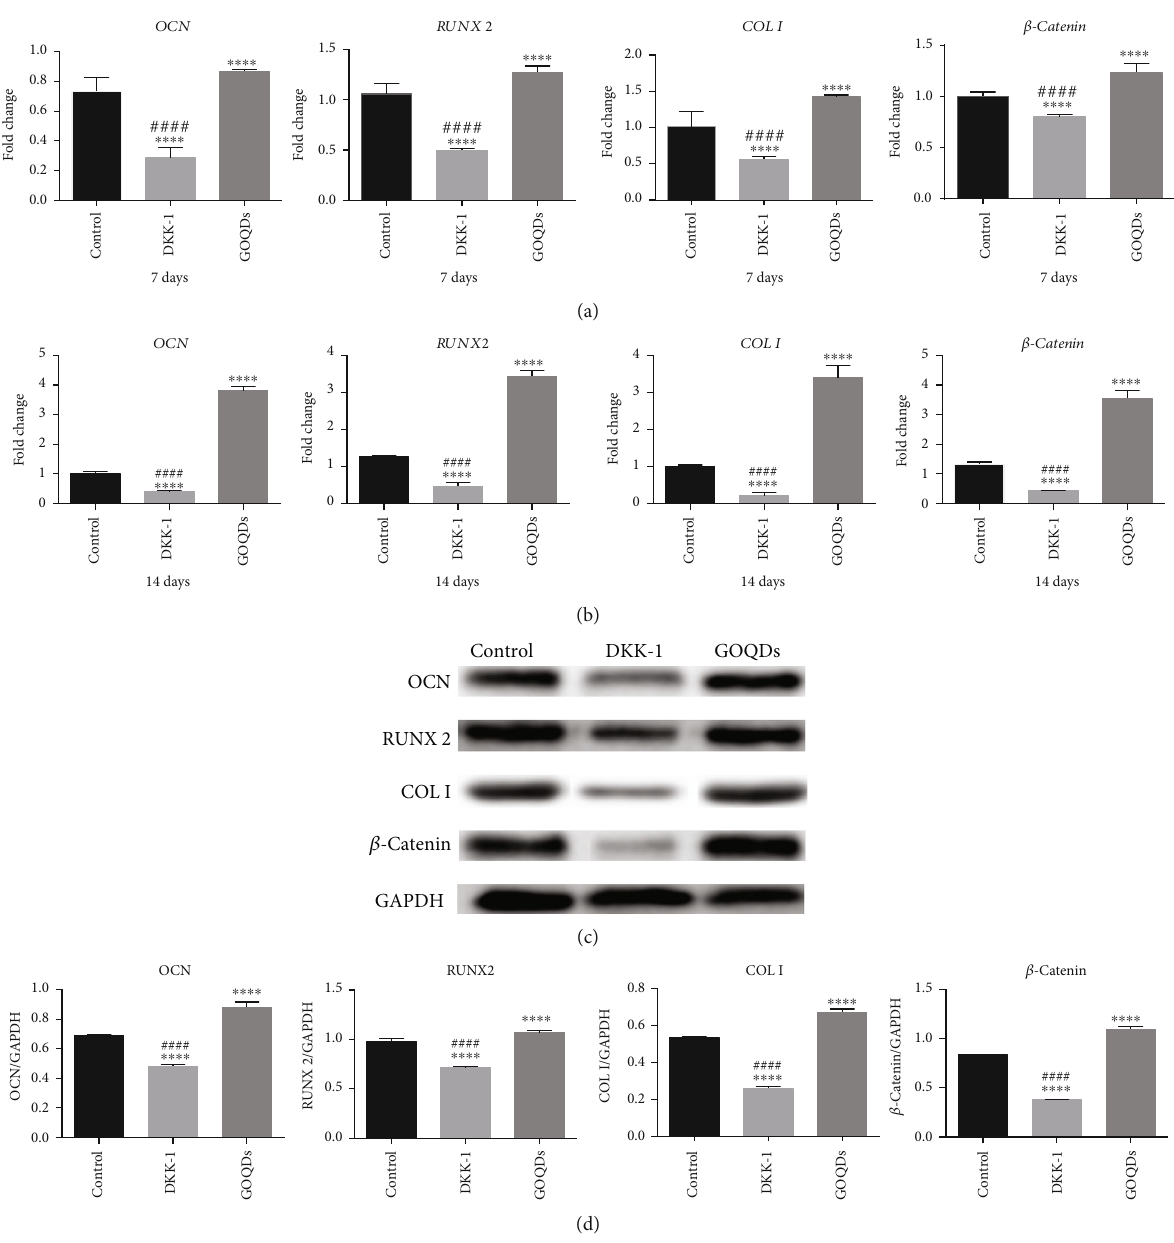
Figure 6: SHEDs were cultured in the osteogenic induction medium containing GOQDs and/without DKK-1. (a) mRNA extracted at 7 days. (b) mRNA extracted at 14 days. (c) Protein extracted at 14 days. (d) Quanti fi cation of protein levels. ∗ p < 0 : 05 , ∗∗ p < 0 : 01 , ∗∗∗ p < 0 : 001 , and ∗∗∗∗ p < 0 : 0001 vs. the control group. # p < 0 : 05 , ## p < 0 : 01 , ### p < 0 : 001 , and #### p < 0 : 0001 vs. the GOQD